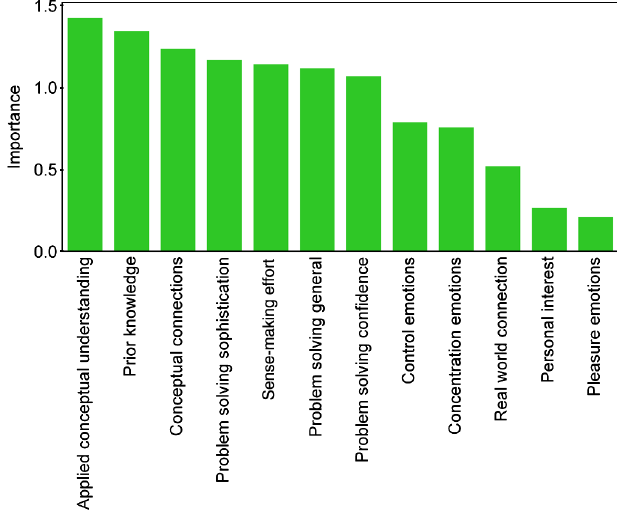
FIG. 2 (color online). Variables of importance in predicting (VIP) lab score . Values larger than 1 indicate important constructs while values lower than 0.5 indicate unimportant